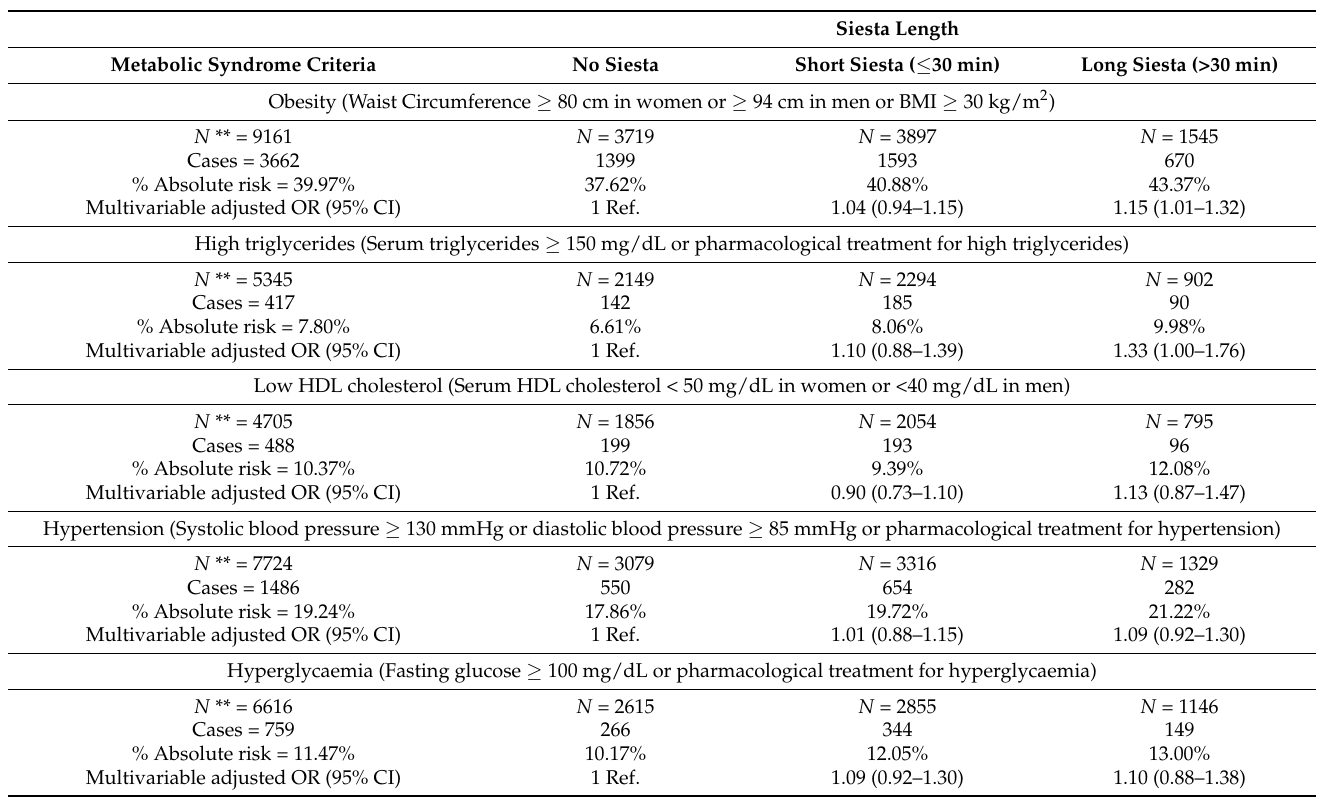
Table 3. Adjusted odd ratios (aOR) * and 95% confidence intervals (CI) for the development of metabolic syndrome criteria according to siesta length in the SUN